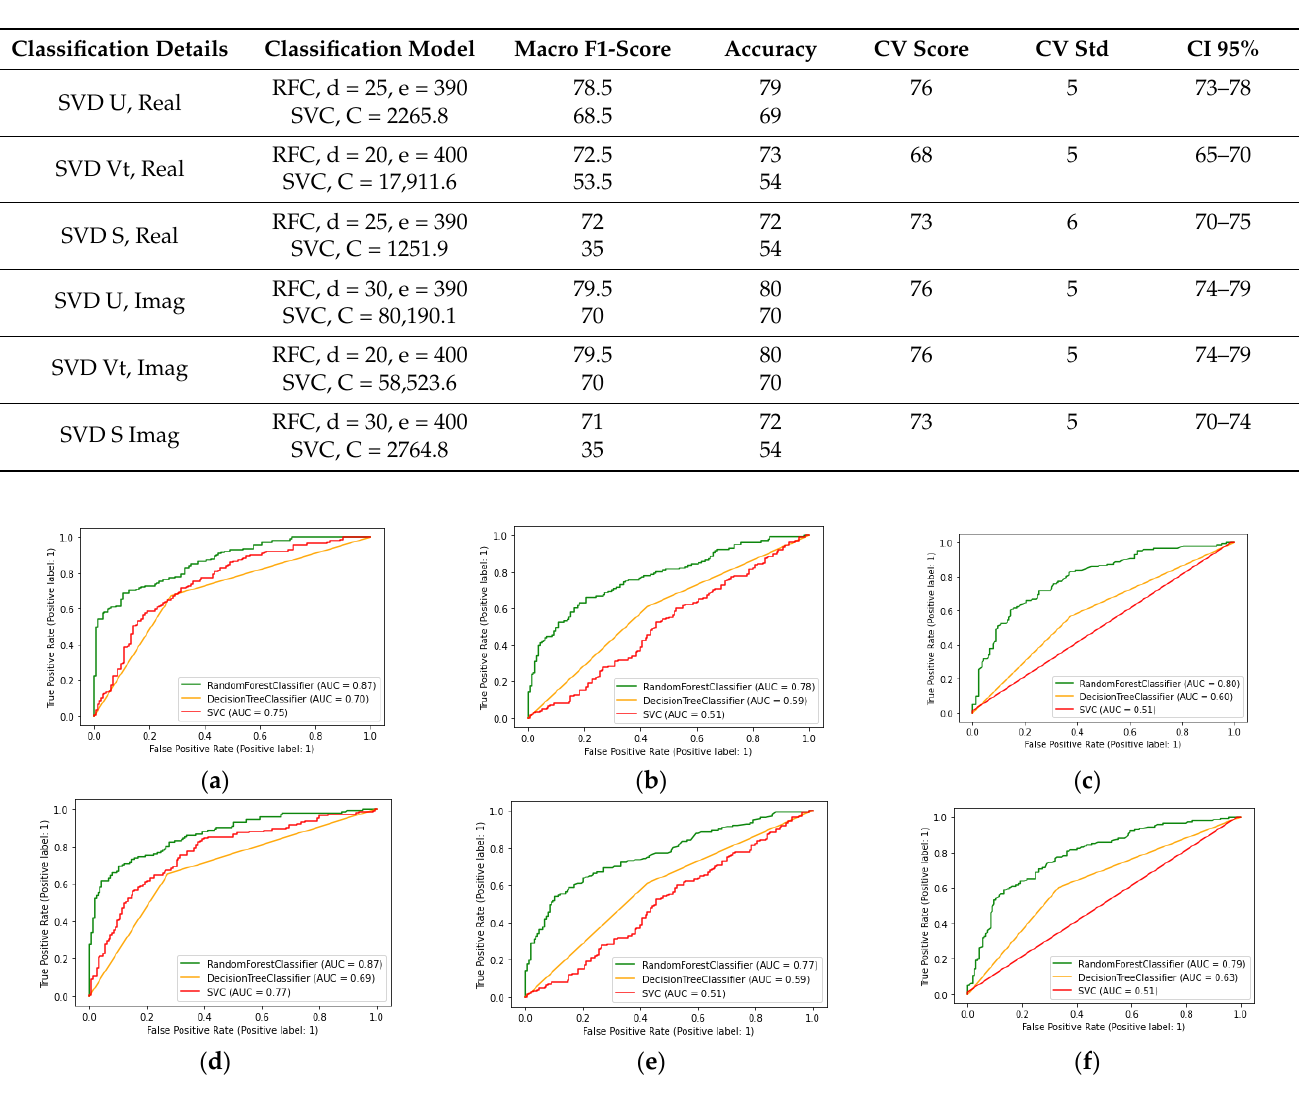
Figure 1. ROC curves of classification models of each SVD element and real and imaginary compo- nents: ( a ) ROC curves of real components of SVD U element; ( b ) ROC curves of real component of SVD V T element; ( c ) ROC curves of real component of SVD S element; ( d ) ROC curves of imaginary component of SVD U element; ( e ) ROC curves of imaginary component of SVD V T element; ( f ) ROC curves of Imaginary component of SVD S element.